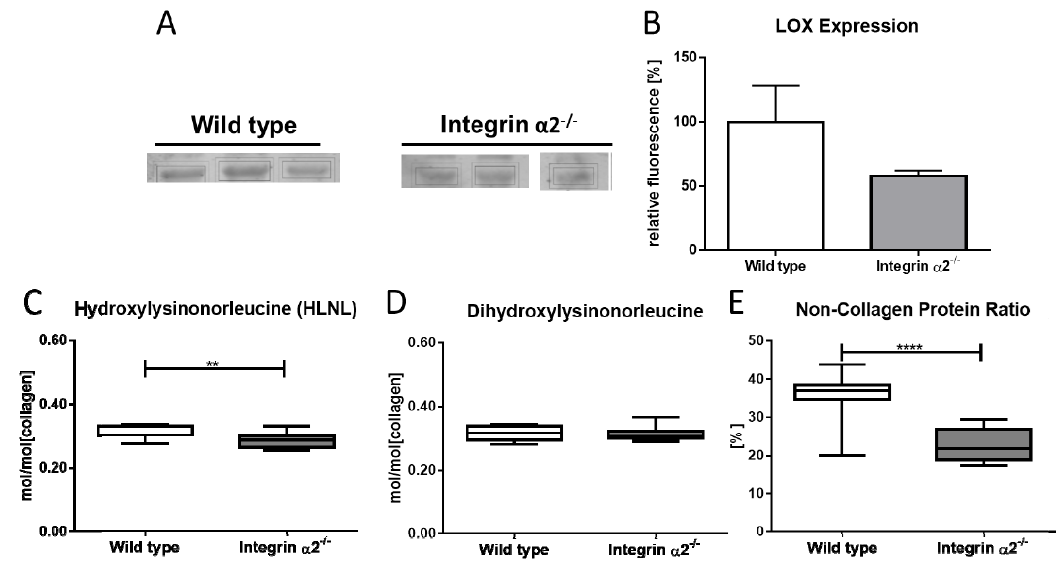
Figure 4. Lysyl oxidase and its activity in integrin α 2 β 1-deficient tendons ( A ). Ten percent polyacrylamide gel electrophoresis with consecutive Western blot detecting for lysyl oxidase. Detection was done in a Li-Cor Odyssey CLx fluorescence scanner using a fluorescent secondary antibody. Quantification was done using the provided image studio software (N = 3, B ). Cross-link analysis of integrin α 2 β 1-deficient tendons (N = 12) showed a slight decrease for hydroxylysinonorleucine (HLNL, C) and a no-change status for dihydroxylysinonorleucine (DHLNL). ( D ). Amino acid analysis revealed a marked decrease of the ratio of non-collagenous protein:total protein ( E ). Mann-Whitney U test was used for statistical testing (** p < 0.01, **** p <